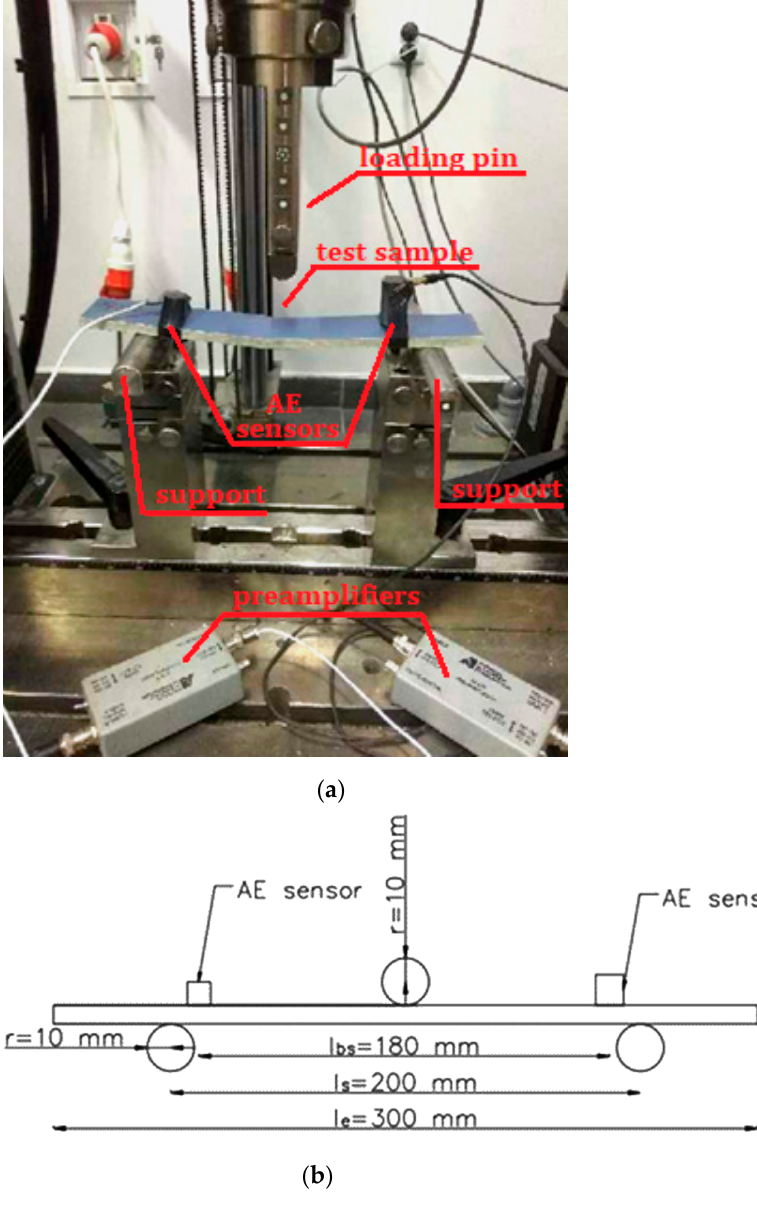
Figure 1. Test stand diagram: ( a ) a photograph of one of the samples and ( b ) the load diagram.